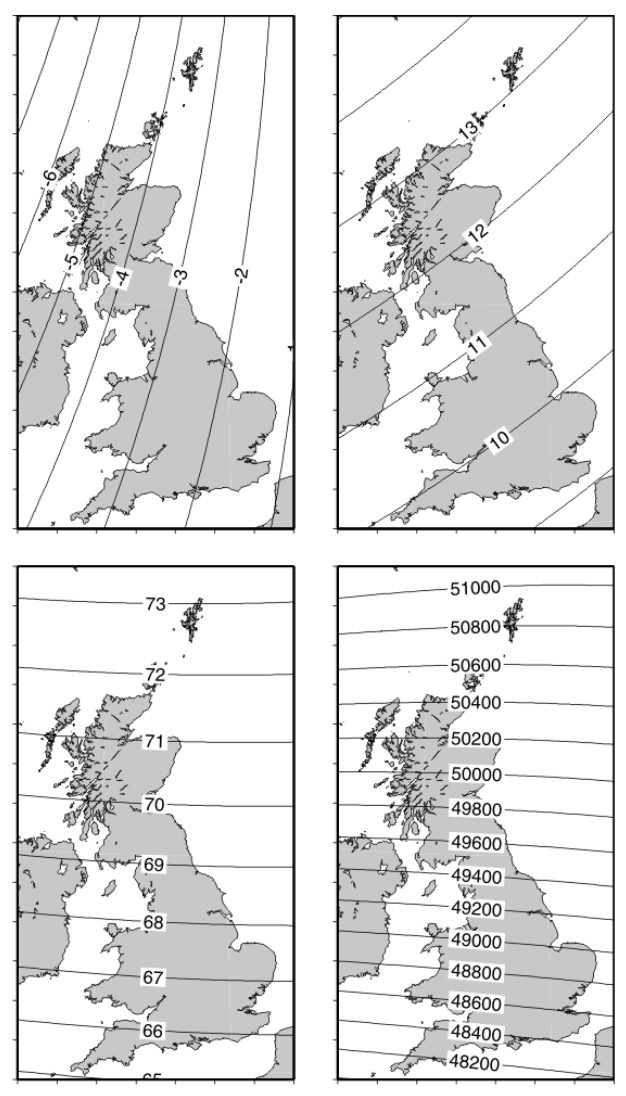
Figure 4. Clockwise: declination, rate of change of declination, total field and inclination for 2010.5.